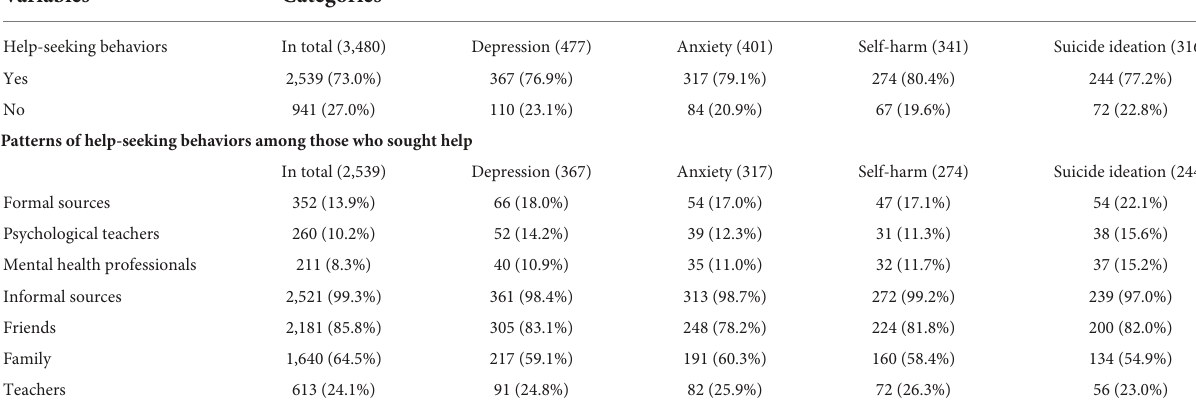
TABLE 3 Help-seeking behaviors and help-seeking sources.